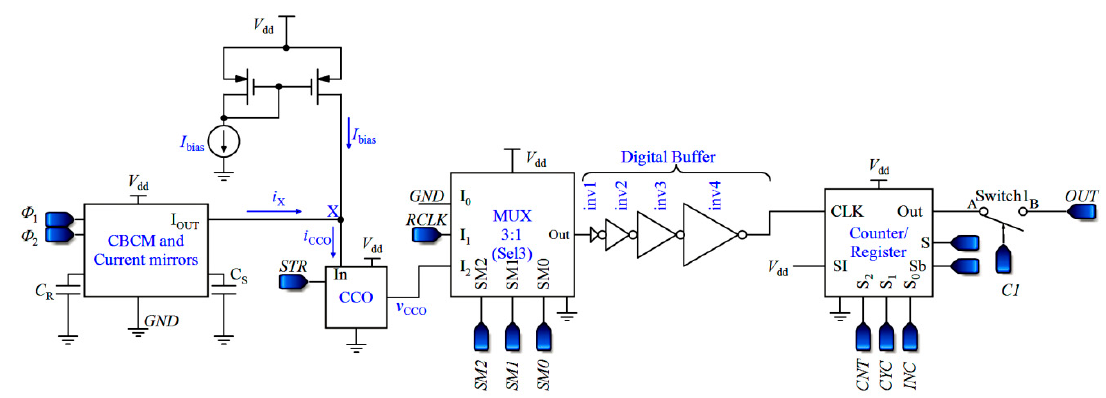
Figure 7. Block diagram of the proposed capacitive sensor.